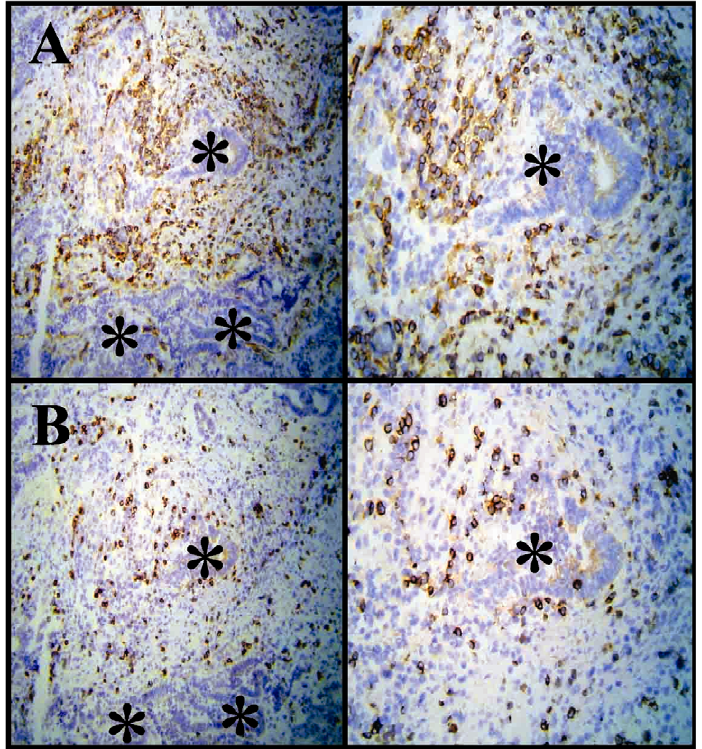
Fig. 3. Immunohistochemical staining using antibodies for CD8 and TNFR-1: Immunohistochemistry shows representative images of CD8 and TNFR-1 expression in tumor infiltrating cells (membranous staining pattern, brown). In serial sections, increased expression of CD8 (A) and TNFR-1 (B) is found adjacent to the tumor (asterisks) in early tumor stages (UICC I/II). DAB brown color, Haemalaun blue color nuclear coun- terstaining. Original magnification: left × 100, right × 200. (The colors are visible in the online version of the article; http://dx.doi.org/10.3233/